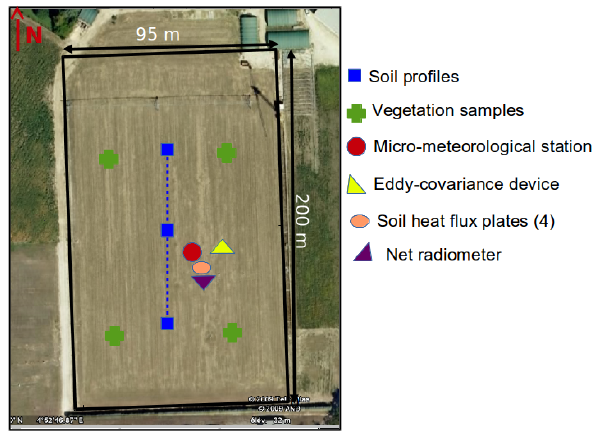
Figure 1. Map of the field site and locations of the instruments. Image from Google Earth,